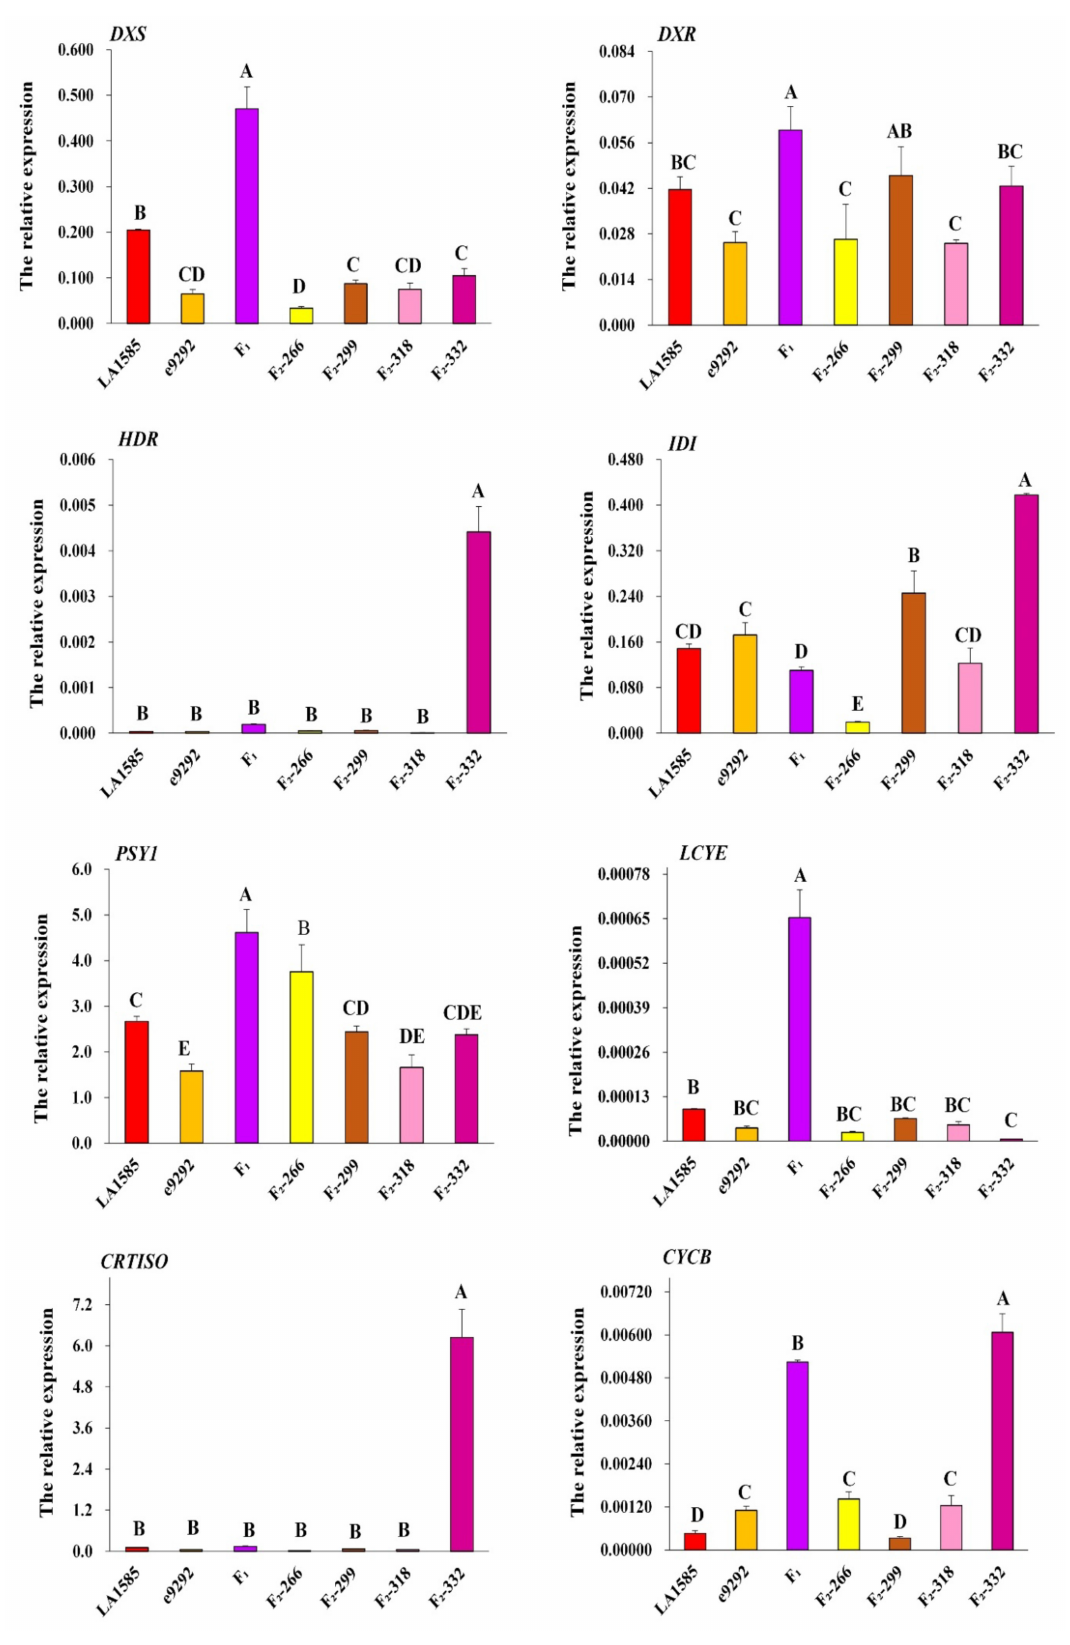
Figure 3. Expression levels of genes associated with the carotenoid synthesis and pathway. The capital letters indicate statistical significance at the p < 0.01 level based on Duncan’s